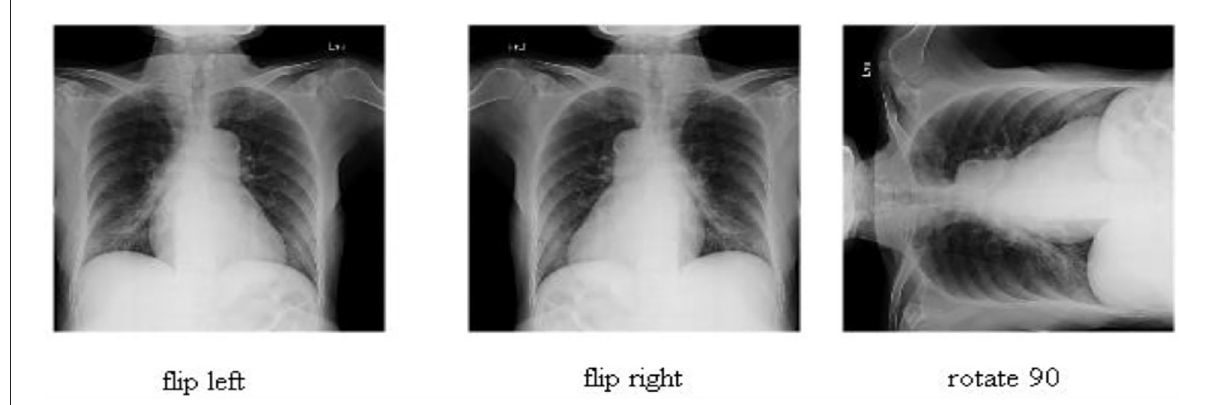
FIGURE2 Sample images after the data augmentation step.